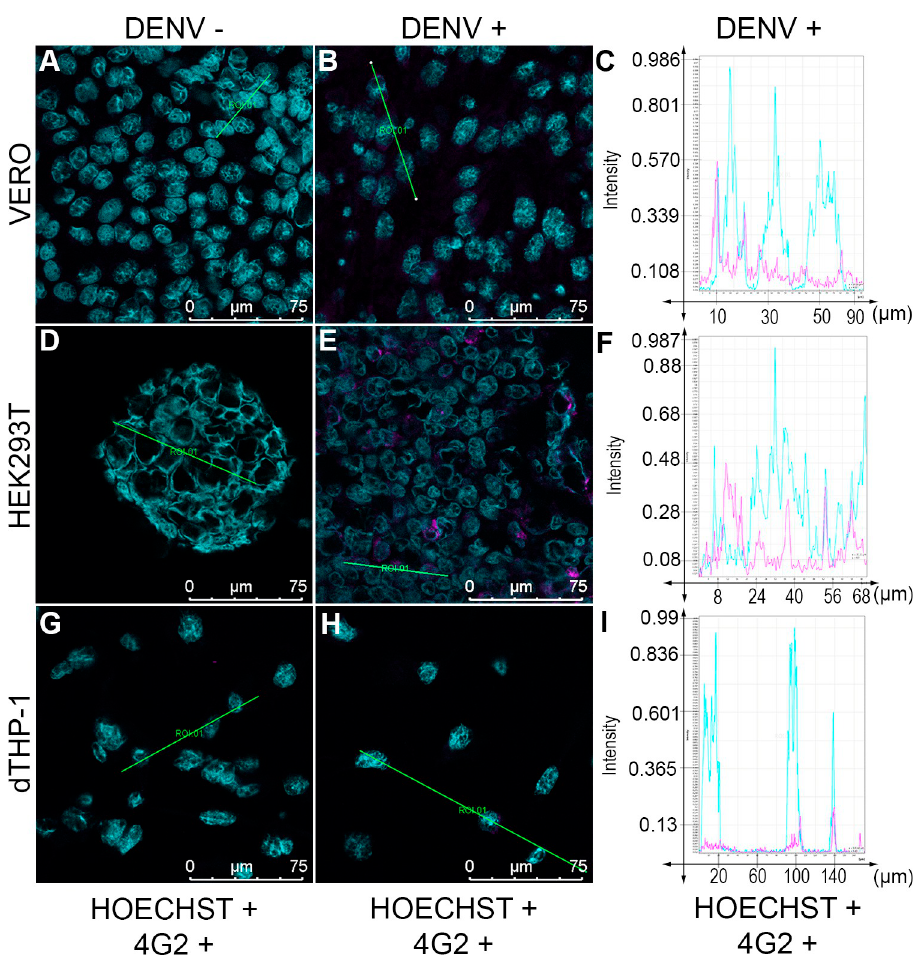
Fig 1. Confocal immunofluorescence of VERO, HEK293T and PMA-treated THP-1 cells infected or not with dengue vaccine. Cells were stained with anti-4G2 (pan-flavivirus antibody, pink fluorescence) and PAFI (DNA staining, blue fluorescence). Negative control (A), (D) and (G), infected cells with 10 − 1 vaccine dilution for 7 days (B), (E) and (H) show positivity for 4G2 in VERO (B) and HEK293T (E) cells. Representative graph of fluorescence intensity (y-axis) against the distance in micrometer (x-axis) of infected cells (C), (F) and (I). Representative images obtained under confocal microscope Leica TCS-SP8 at 200X magnification. n = 2.